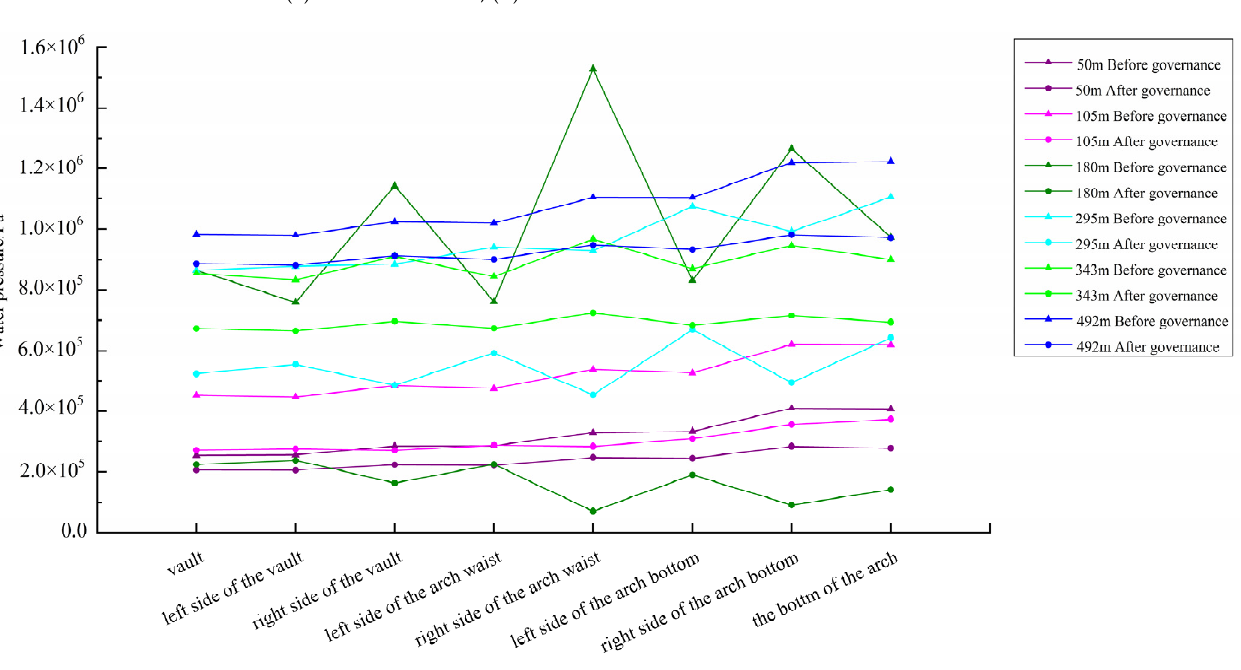
Figure 16. Water pressure at each point before and after management.